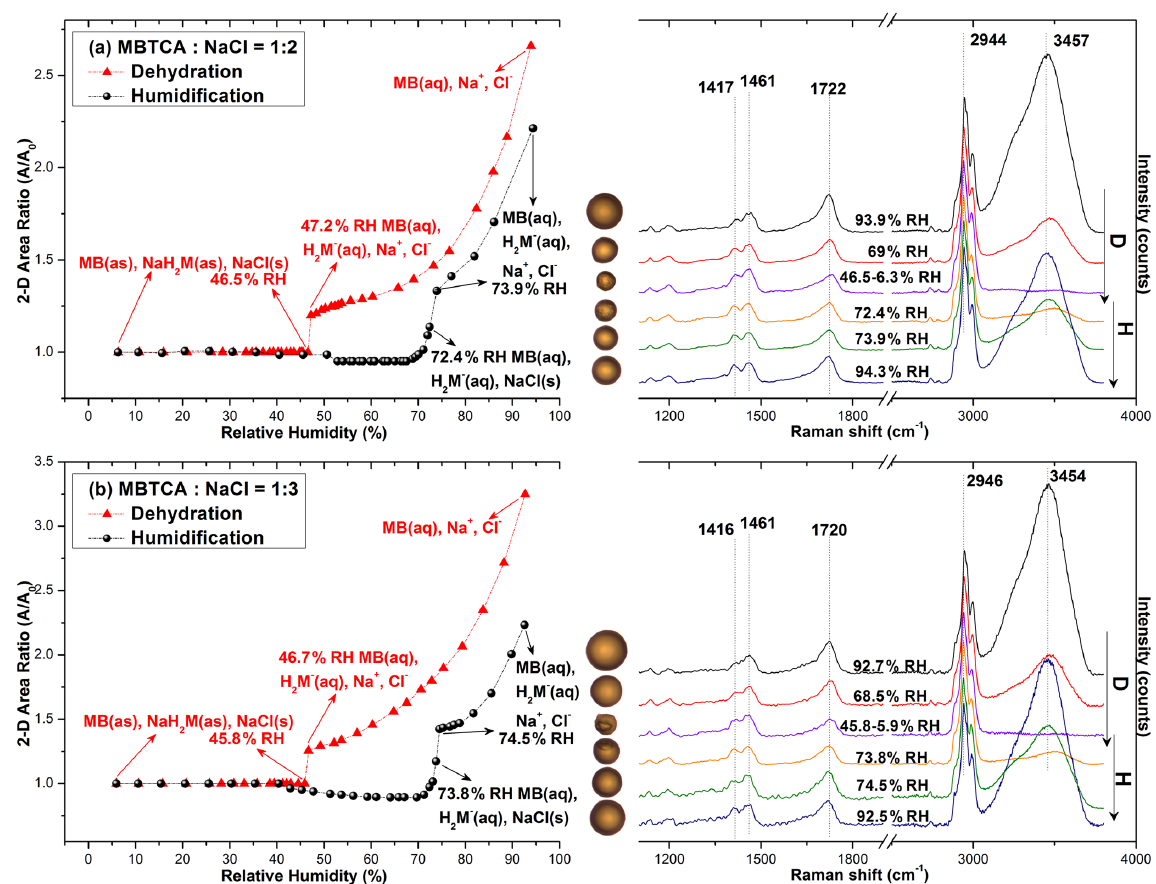
Figure 5. Hygroscopic curves, corresponding optical images, and Raman spectra at specific RHs of MBTCA:NaCl = (a) 1:2 and (b) 1:3. The recorded transition RHs during the dehydration (D) and humidification (H) processes and the chemical compositions of the mixtures at certain RHs are marked with arrows in the hygroscopic curves. The phase notations shown in parentheses are s – solid, aq – aqueous, and as – amorphous